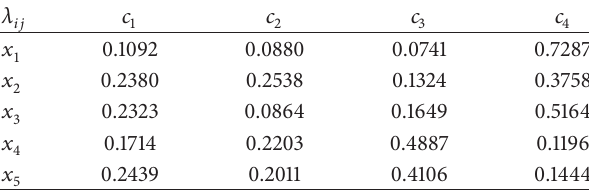
𝑆(̃𝑅) ̃𝑅 Table 9: : score of . Table 10: